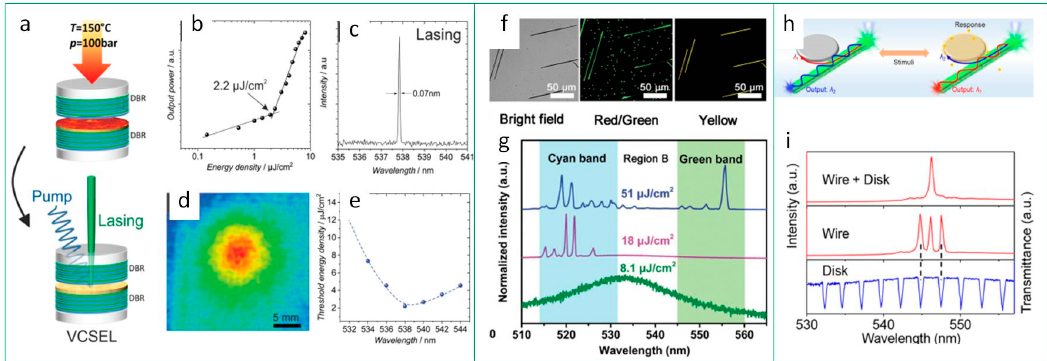
Figure 6. Resonators vs. perovskite material’s morphology. DBR: ( a ) Scheme of vertical-cavity surface-emitting lasers (VCSEL) device; ( b ) output power vs. pump energy density; ( c ) PL spectrum and ( d ) far-field beam distribution at pump energy density above threshold; ( e ) energy density of laser threshold energy vs. the PL peak position. Reproduced with permission [120]. Copyright